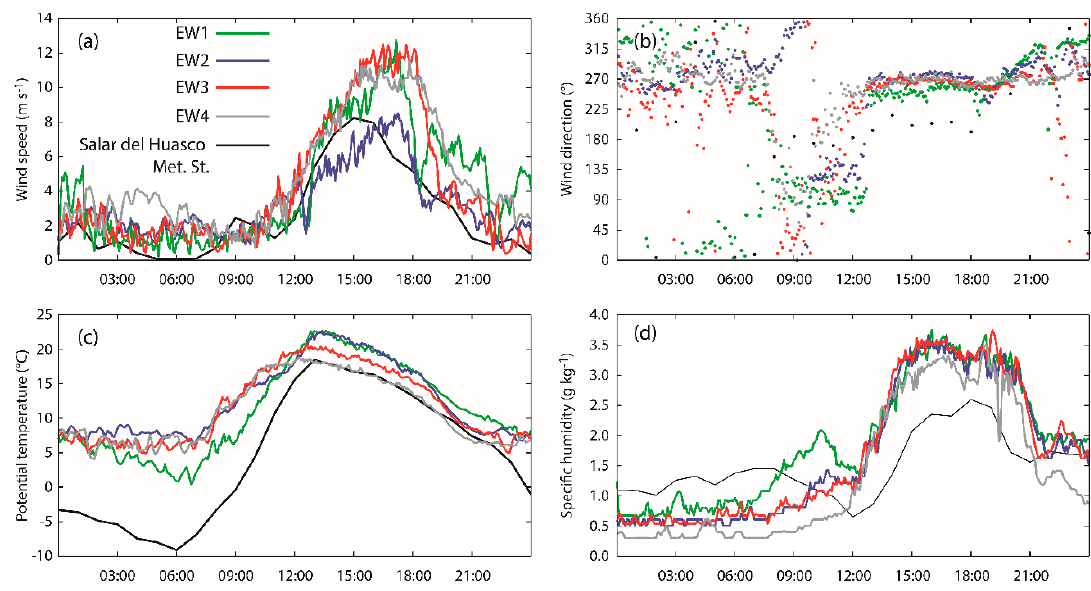
Figure 4. Meteorological data obtained in the EW transect for November 15, 2018: (a) wind speed; (b) wind direction; (c) potential temperature; and (d) specific humidity. The location of the meteorological stations is shown in Figure 2.